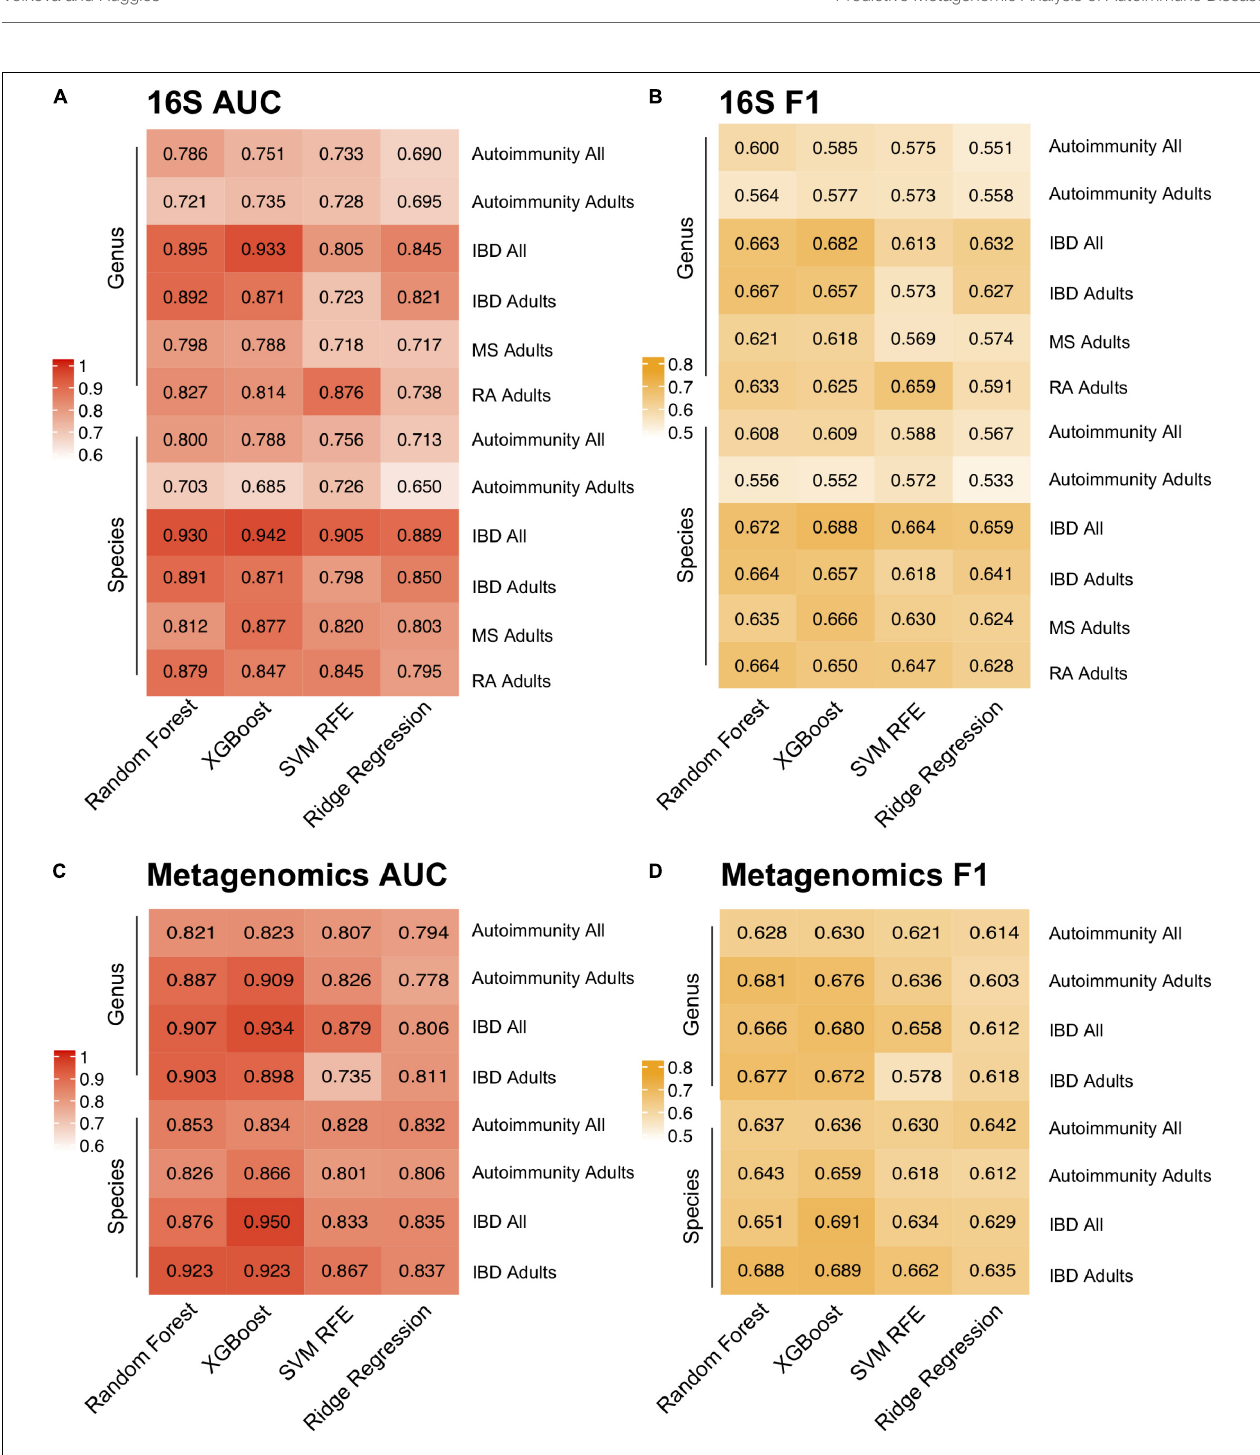
FIGURE 3 | Predictive Modeling of Autoimmune Disease. Area under the curve (AUC) (A,C) and F1-scores (B,D) for models predicting any autoimmune disease, inflammatory bowel disease (IBD), multiple sclerosis (MS) and rheumatoid arthritis (RA) for four machine learning models, random forest, XGBoost, support vector machine with recursive feature elimination (SVM RFE) and ridge regression and at the genus and species level. Adult-only (18 years and older) and All (adult + children) models are included for general autoimmunity and IBD studies.